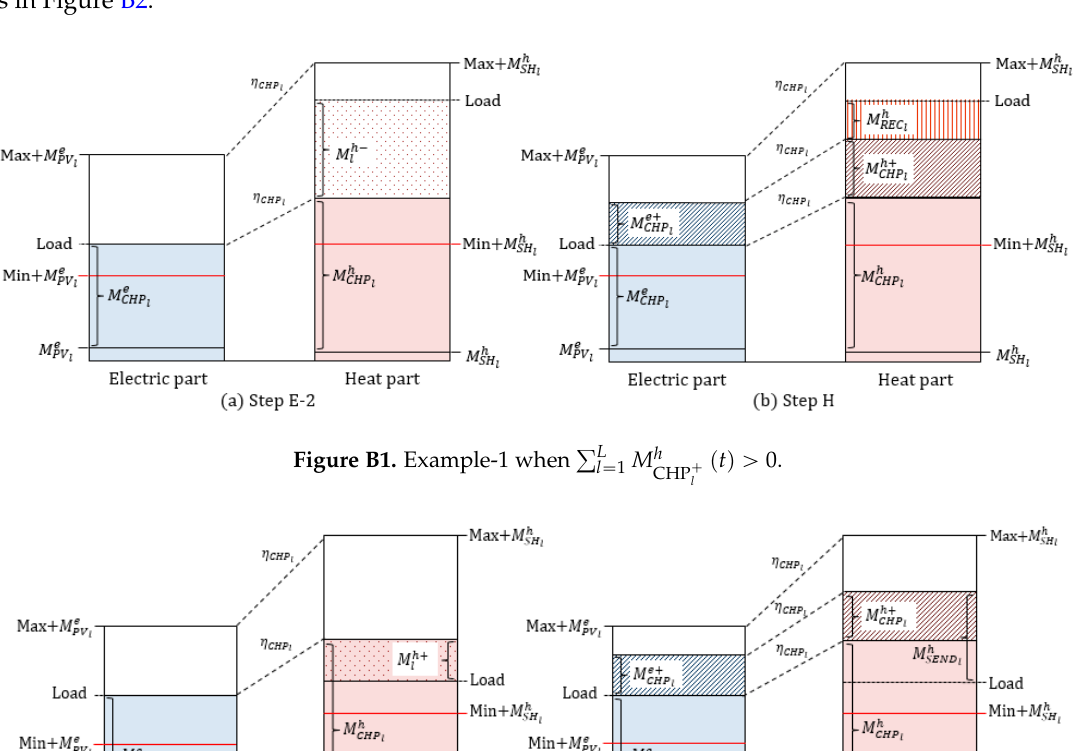
ř L p t q ą M h l “ 1 CHP ` l